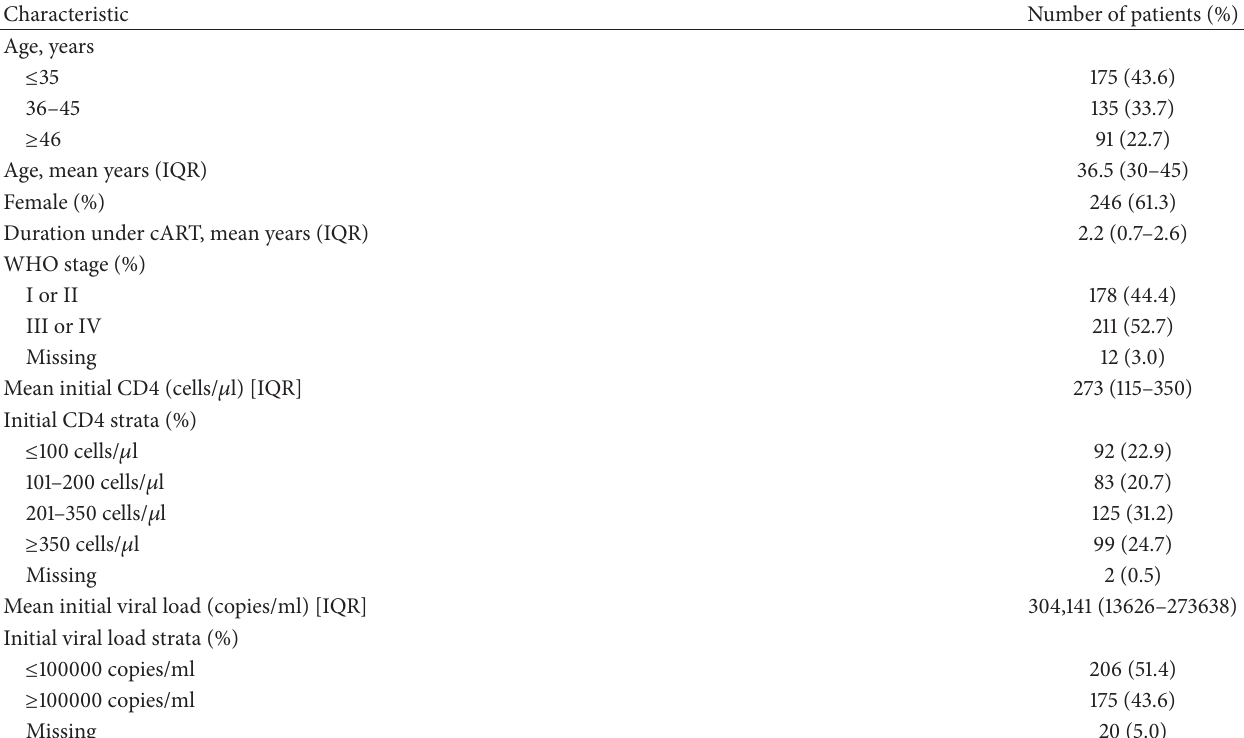
Table 1: Baseline characteristics of the study participants.